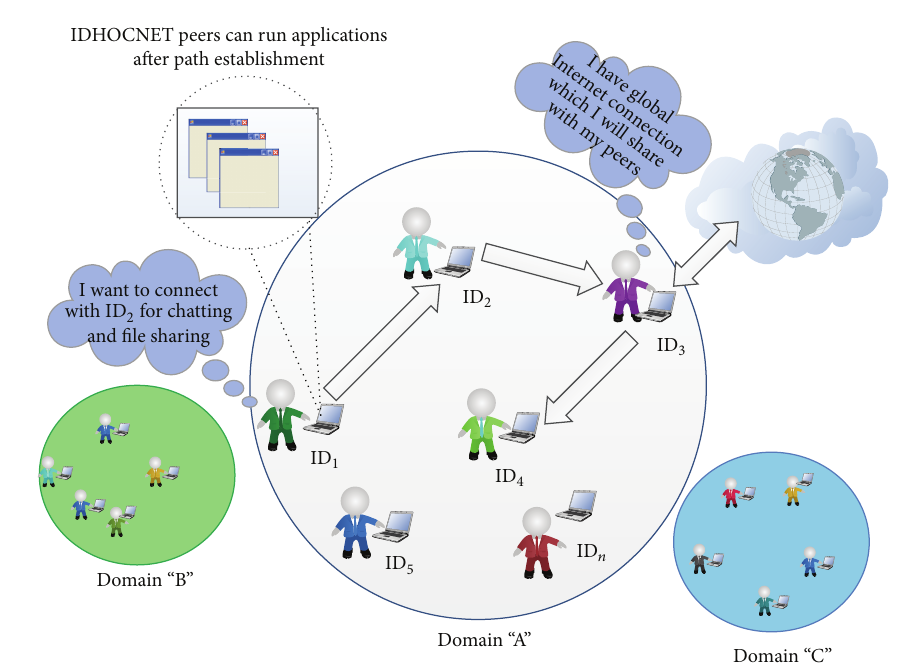
Figure 7: Abstract view of IDHOCNET formation in different